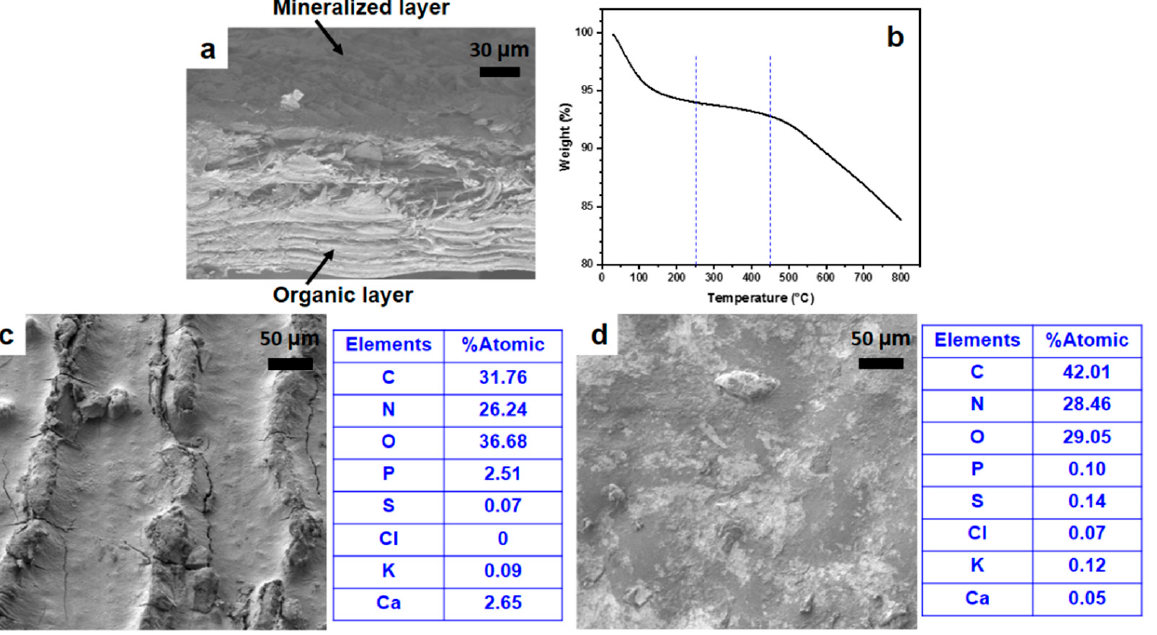
Figure 1. ( a ) A cross sectional-view SEM image of a raw fish scale, ( b ) TGA curve of raw fish scales, ( c ) a top-view SEM image of a mineralized surface, and ( d ) a top-view SEM image of an organic surface of the raw fish scale. Table 1. Composition of the fish scale biochar products analyzed by EA and EDXRF.